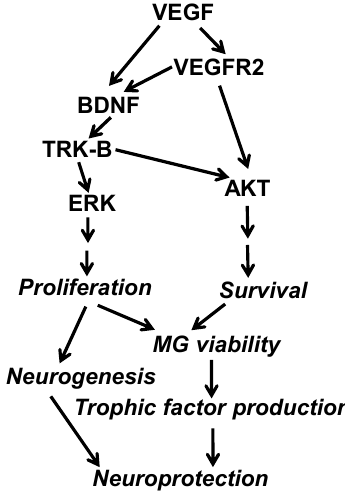
Figure 4. Working hypothesis and mechanisms of VEGF-mediated MC viability and neuroprotec- tion, based on our previous and current work. VEGF plays a cardinal role for neuroprotection in DR and hypoxic retinal disorders through its own action (VEGFR2/AKT-mediated MC survival) and through its downstream neurotrophin-mediated MC viability, including BDNF/TRK-B-mediated MC proliferation and survival. As a result, MCs exert the neuroprotective function by trophic factor production and neurogenesis.